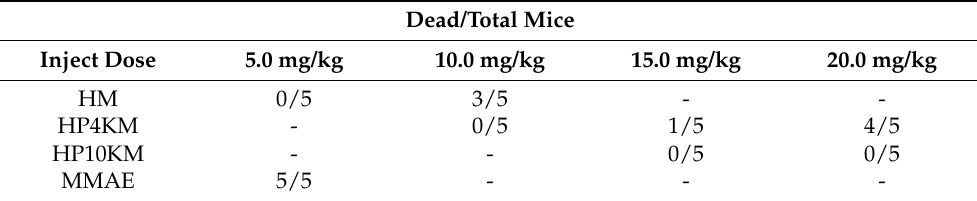
Table 1. In vivo off-target toxicity of the conjugates and free monomethyl auristatin E (MMAE). Dead/Total Mice Inject